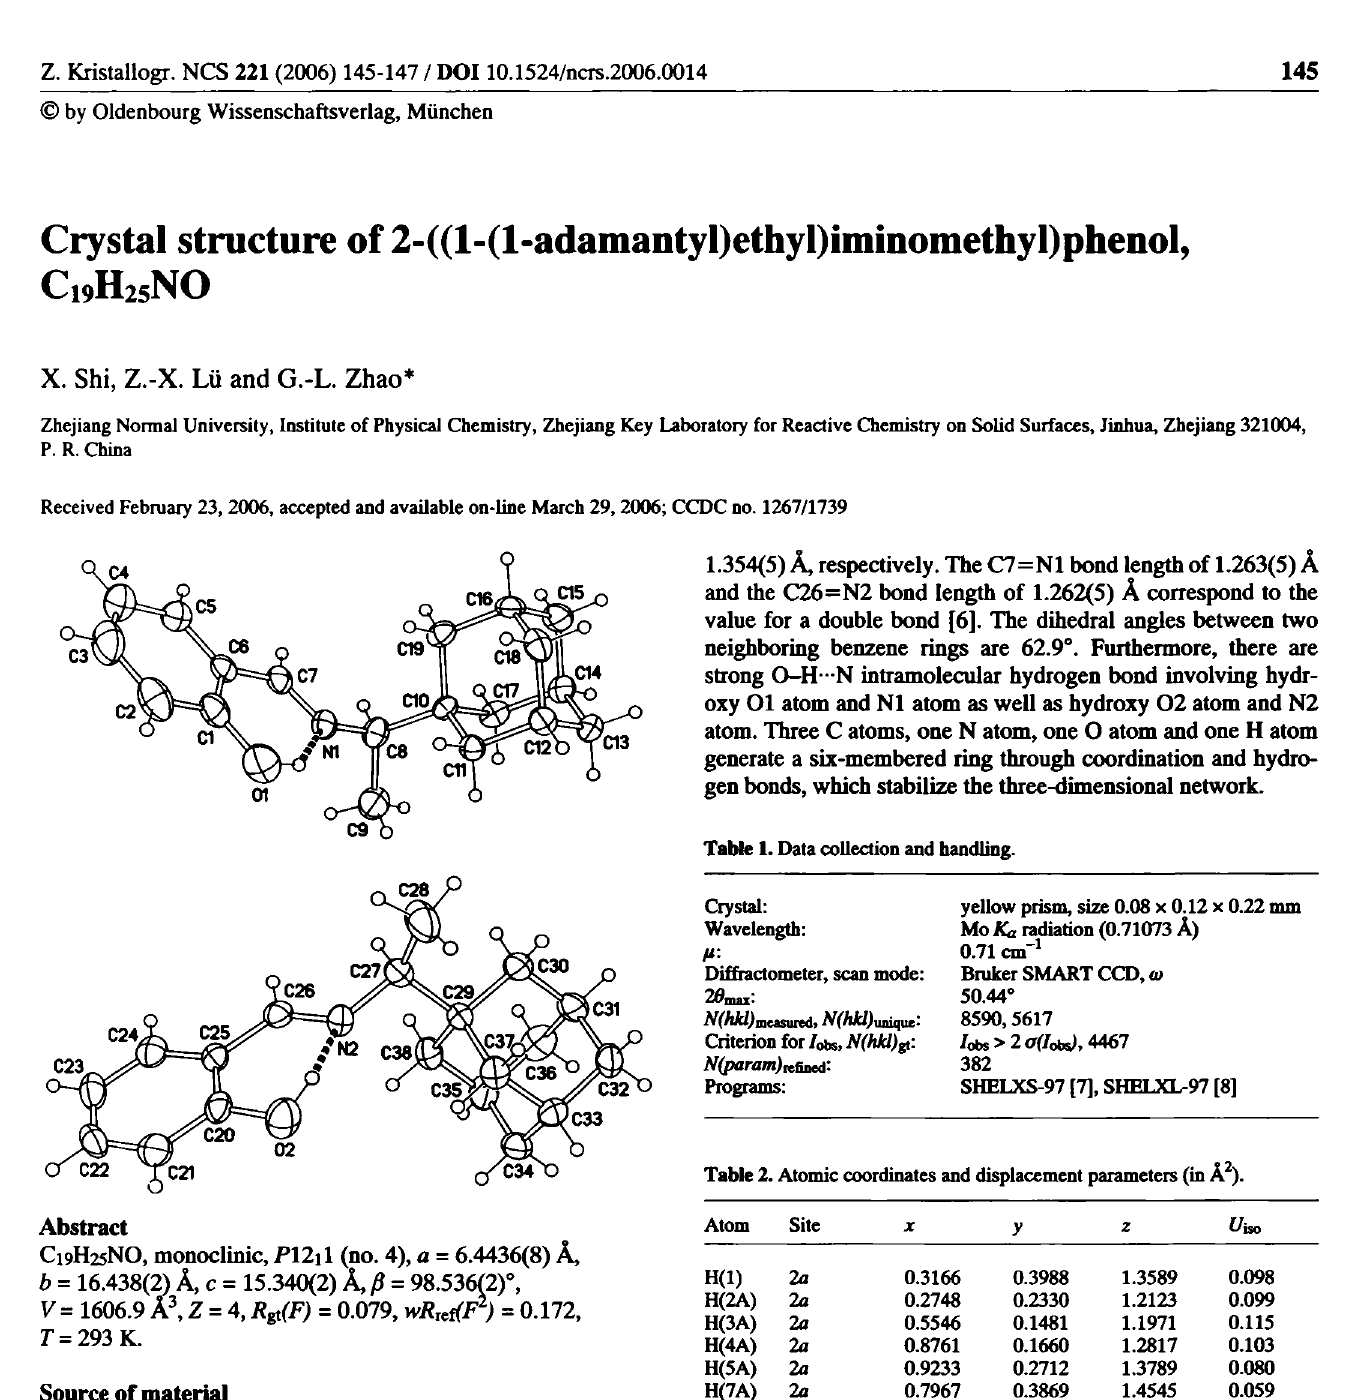
Table 2. Atomic coordinates and displacement parameters (in A 2